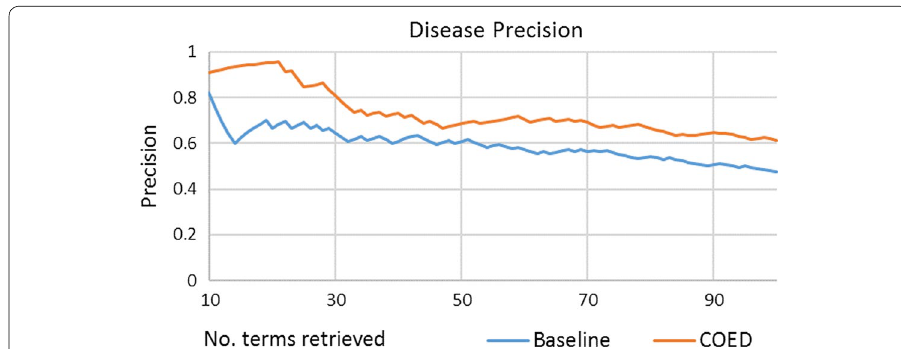
Fig. 6 Comparison of disease precision for baseline and COED methodologies